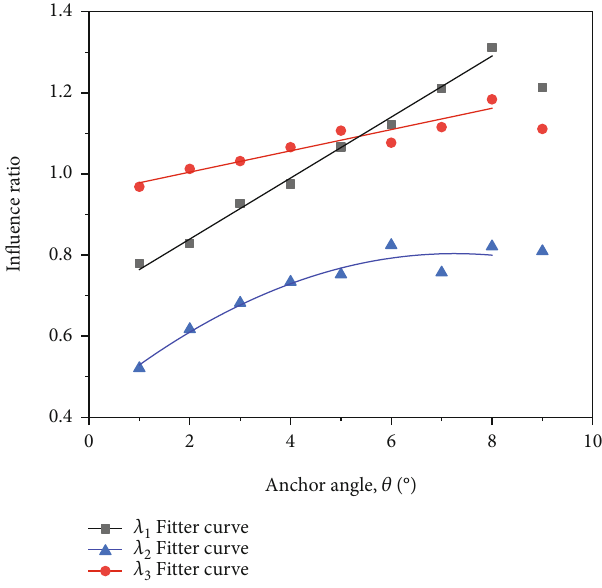
Figure 5: In fl uence ratio of the soil displacement as a function of anchor angle for D = 27 % and E / D = 3 r